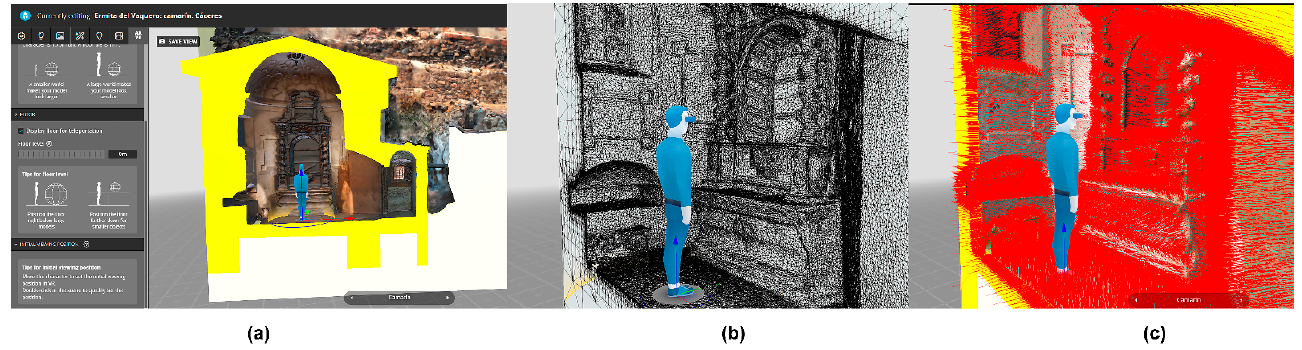
Figure 22. ( a ) Determinacion de la posición inicial del avatar para VR; ( b , c ) Escalado del modelo respecto de la malla.